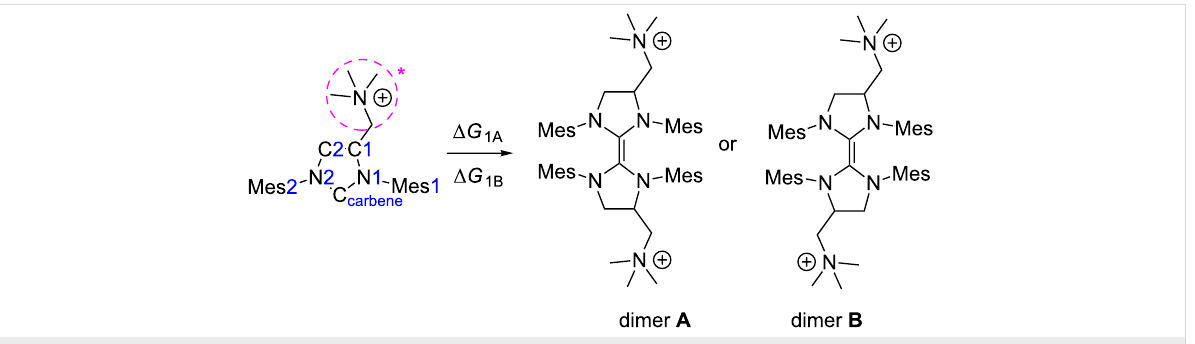
Scheme 2: Schematic representation of carbene dimerization and atom numbering scheme used throughout this work.